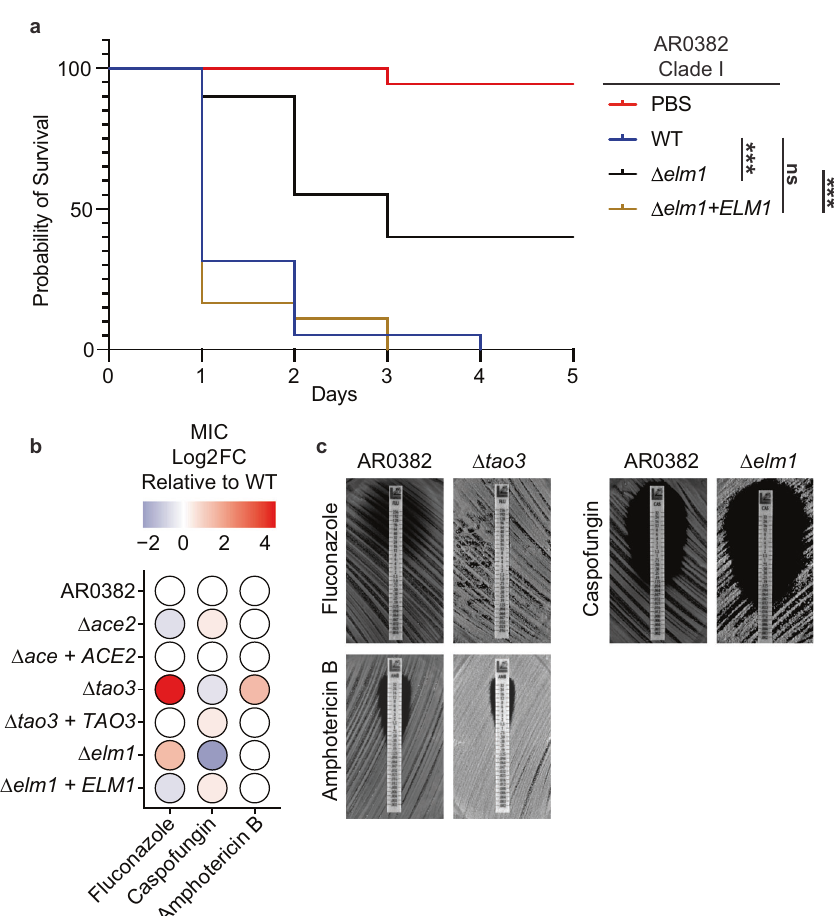
Fig. 6 C. auris morphogenic mutants show attenuated virulence and altered antifungal susceptibility. a Wild-type AR0382 (Clade I), Δ elm1 , and Δ elm1 + ELM1 strains in the AR0382 background were standardized to an optical density of OD = 1.0 in PBS before inoculating 20 Galleria mellonella 600 larvae per C. auris strain with 50 μ L of prepared inoculum. Larvae were maintained at 37 °C and monitored daily for survival for 5 days. Source data are provided as a Source Data fi le. Statistical differences were determined using a Mantel − Cox log-rank test. WT- Δ elm1 , *** p < 0.0001; WT- Δ elm1 + ELM1 , ns: p = 0.51; Δ elm1- Δ elm1 + ELM1 , *** p < 0.0001. b Gradient MIC test strips were used to determine the susceptibility of wild-type AR0382, morphogenic mutants, and complemented strains in the AR0382 background to fl uconazole, caspofungin, and amphotericin B. The color and intensity of each point corresponds to the Log 2 fold change in MIC for each strain relative to the wild type. A complete list of MICs is available in Supplementary Table 1. c MIC test strips with zones of inhibition for mutants with substantially altered antifungal susceptibilities. Δ tao3 exhibited reduced susceptibility to fl uconazole and amphotericin B compared to the wild type. Δ elm1 exhibited increased susceptibility to